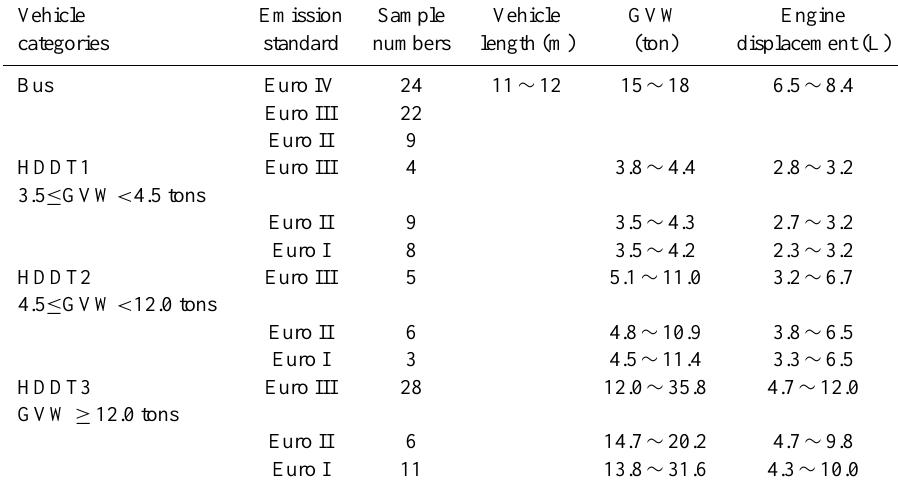
Table 2. Summary of test